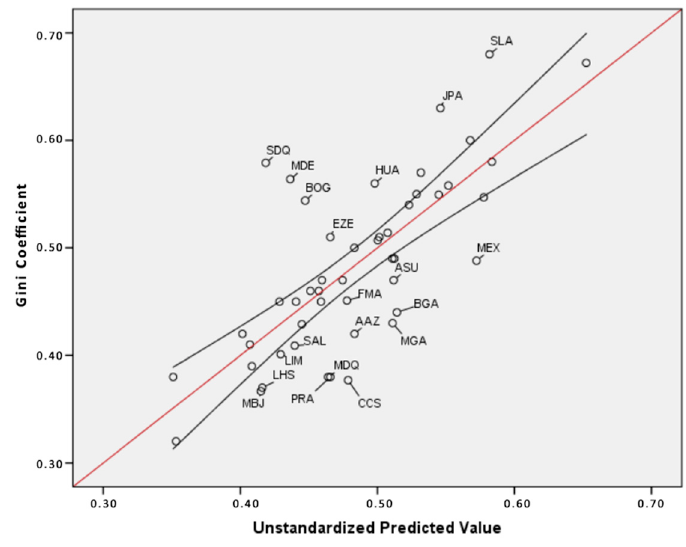
Figure 4. Expected vs. actual values for GIN.